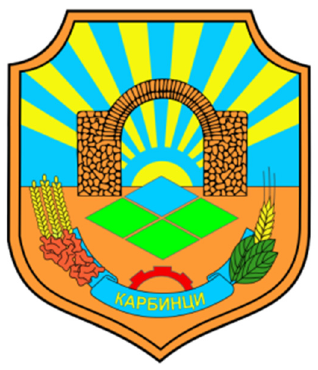
Figure 13. Arms with sun with divergent rays: Karbinci.